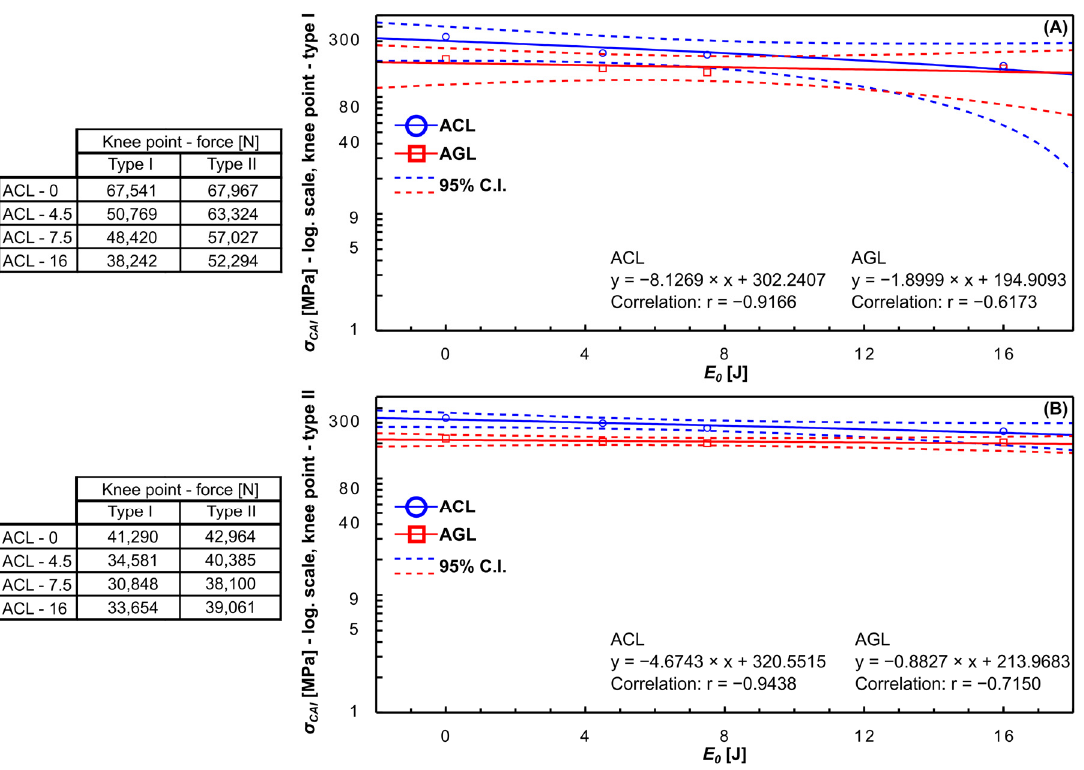
Figure 7. The relation of impact energy and knee point force/stress values detected on CAI test characteristics for type I ( A ) and type II estimation methods ( B ).